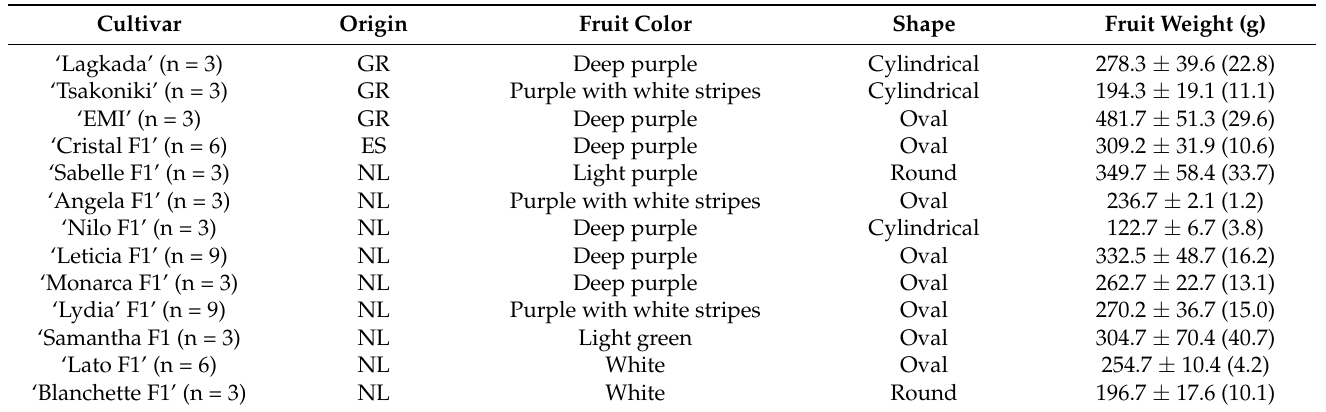
Table 1. Eggplant cultivars that were studied; origin and fruit’s color and shape of each cultivar; average fresh fruit weight and standard deviation. Values in parentheses represent the standard error (SE) of the measurements; n: the number of biological